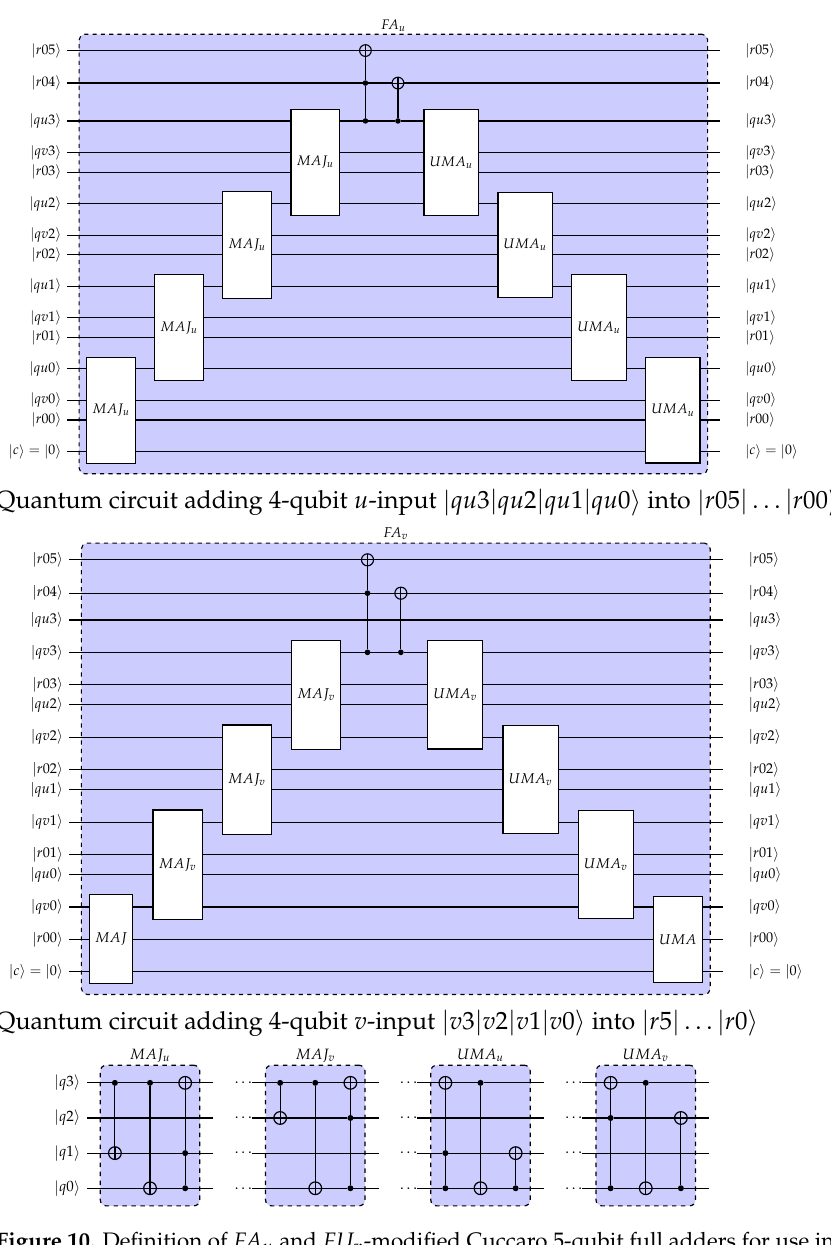
Figure 10. Definition of FA u and FU v -modified Cuccaro 5-qubit full adders for use in shift-and-add- based squaring for N M =